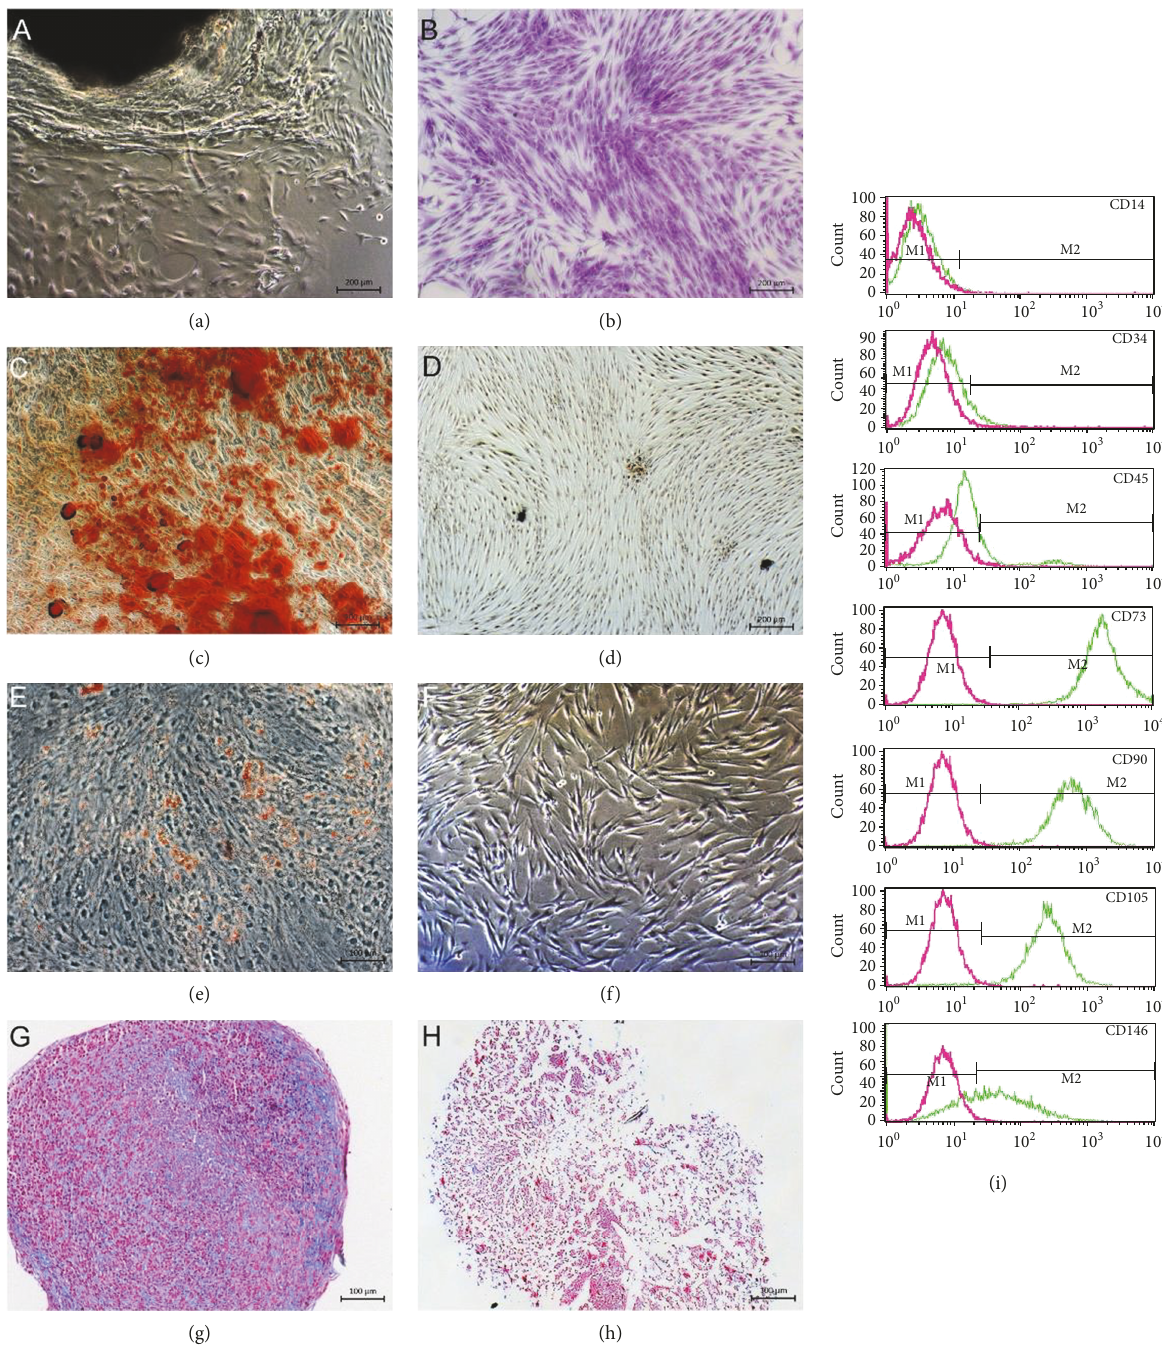
Figure 1: Isolation and characterization of G-MSCs. (a) Microscopic appearance of outgrowing cells from free gingival margin. (b) Microscopic appearance of G-MSCs stained with crystal violet. (c) Alizarin red staining of G-MSCs after osteogenic induction. (d) Alizarin red staining of G-MSCs cultured in a basic medium . (e) Oil Red O staining of G-MSCs after adipogenic stimulation. (f) Oil Red O staining of G-MSCs cultured in a basic medium . (g) Alcian blue staining of G-MSCS after chondrogenic stimulation. (h) Alcian blue staining of G-MSCs cultured in a basic medium . (i) Flow cytometry analysis of cell surface markers of